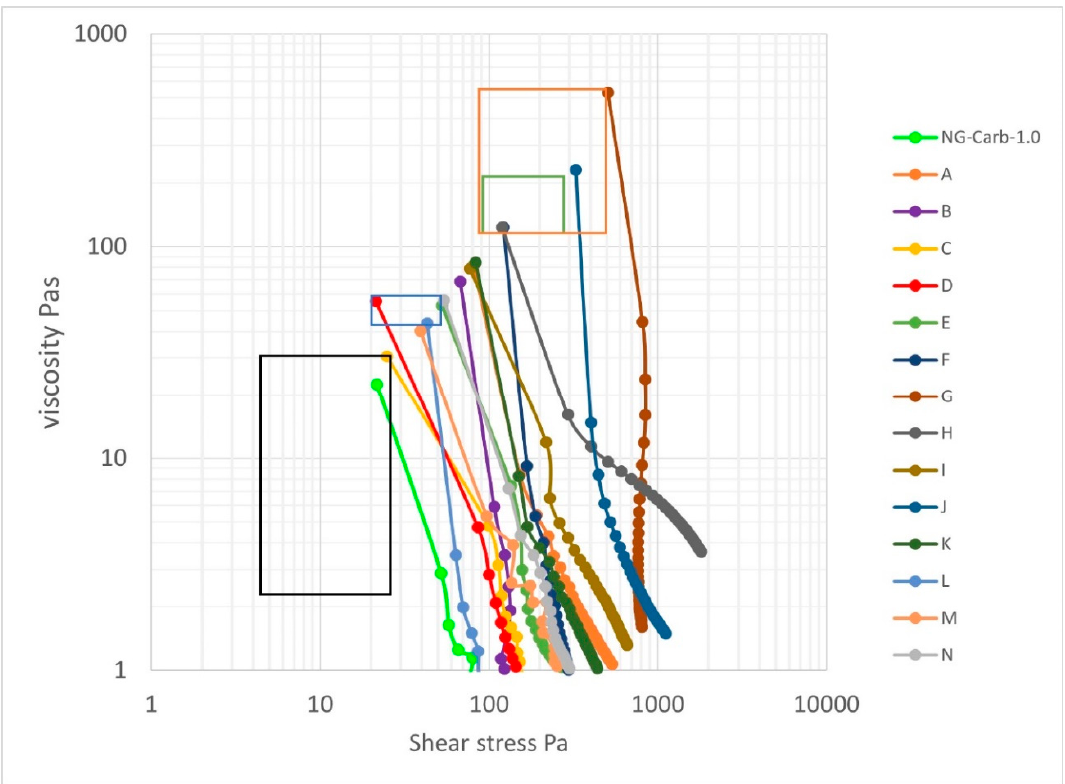
Figure 5. Viscosity curves of samples A-N and NG-Carb-1.0 plotted on the Brummer et al. window for the evaluation of good primary skin feeling. Ointments—green rectangle; emulsions—orange rectangle; gels—blue rectangle; nanoemulsion—black rectangle.